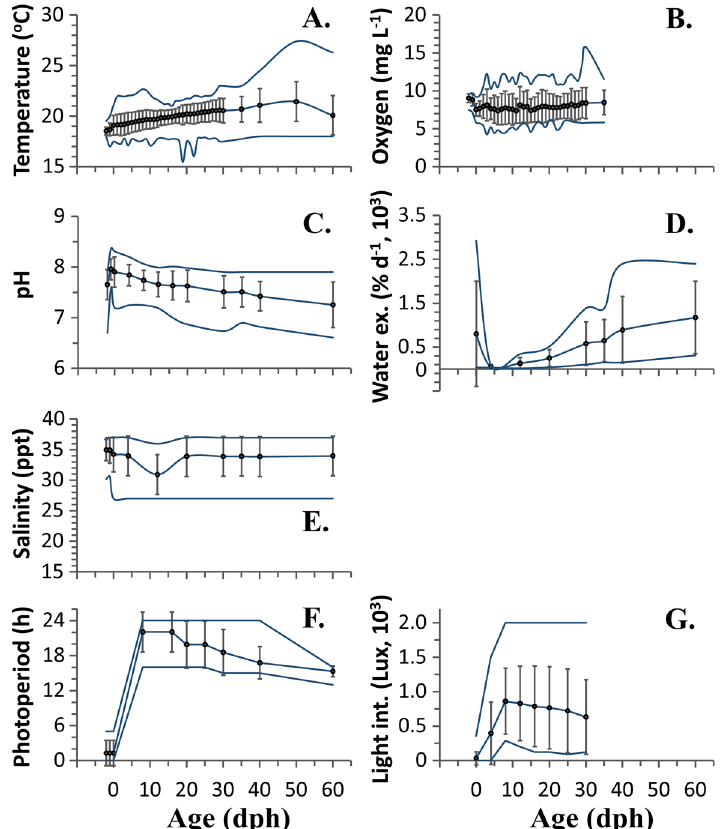
Figure 1. Mean (± SD), min and max values of the basic abiotic conditions applied during the embryonic period and larval rearing of gilthead seabream in 4 European hatcheries. ( A ) Water temperature (°C). ( B ) Oxygen concentration (mg/L). ( C ) pH. D. Daily water exchange rate (% of tank volume). ( E ) Salinity (ppt). ( F ) Photoperiod (duration of light, hours). ( G ) Light intensity on the water surface (Lux). dph, days post hatching.